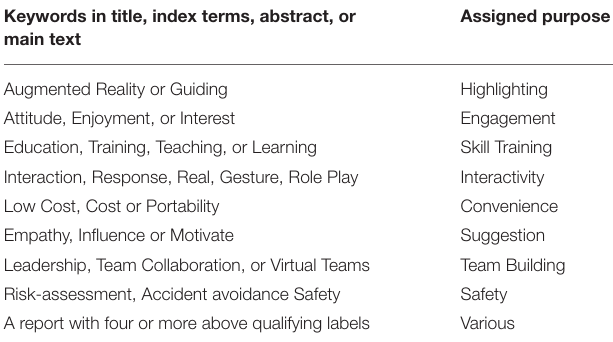
Education. Keywords in title, index terms, abstract, or main